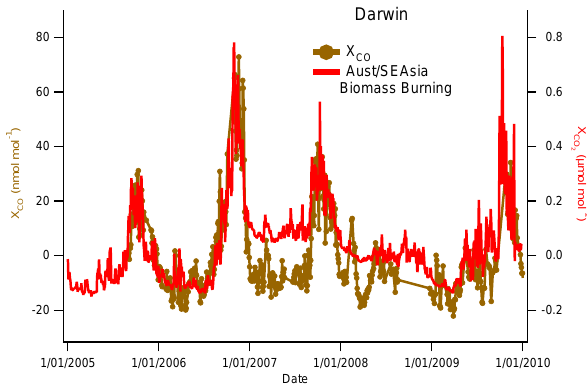
Figure 9. Linearly detrended time series of X CO measured by the TCCON FTS at Darwin (brown) and the modelled contribution of local (Australian and Southeast Asian) biomass burning to the X CO